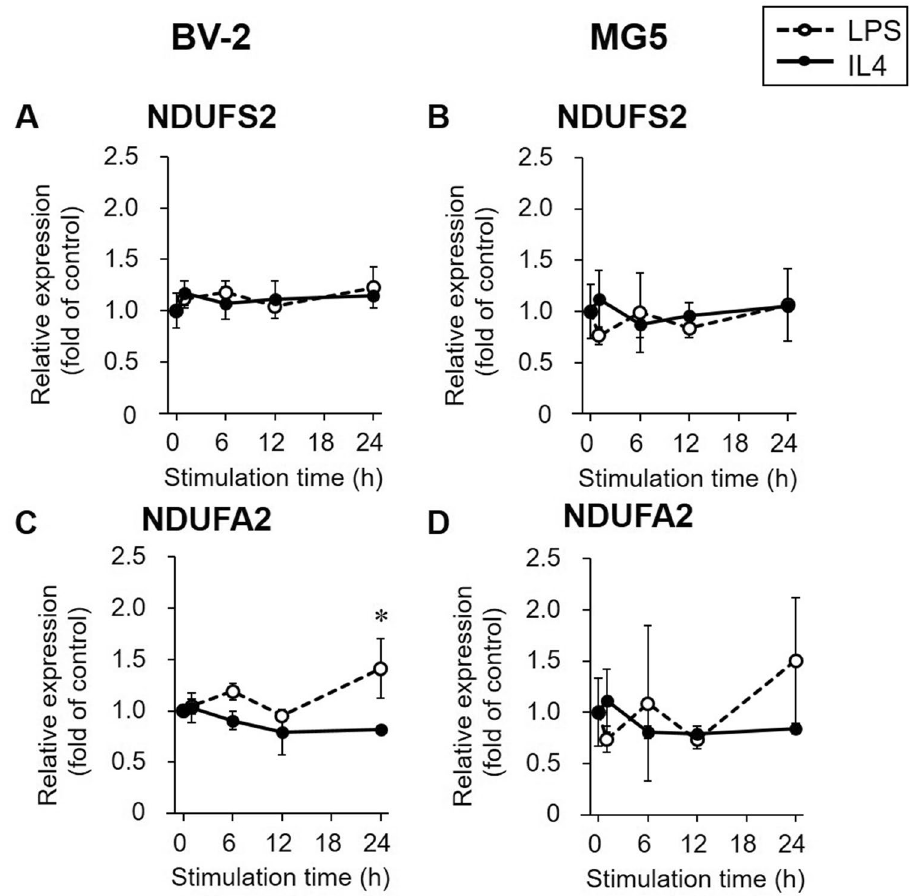
Figure 4. Gene expression of mitochondrial complex I subunits. Relative gene expression levels of mitochondrial complex I subunits NADH: ubiquinone oxidoreductase core subunit S2 (NDUFS2, A and B ) and NADH: ubiquinone oxidoreductase subunit A2 (NDUFA2, C and D ) were determined by RT-PCR in LPS (1000 ng/mL, open circle and dashed line)- or IL4 (60 ng/mL, closed circle and solid line)-stimulated BV-2 and MG5 cells. The results are presented as the fold change relative to the control group (0 h stimulation) and the means ± SDs of three samples. Statistical differences were analyzed by ANOVA followed by Dunnett’s multiple comparison test; * p < 0.05 compared with the